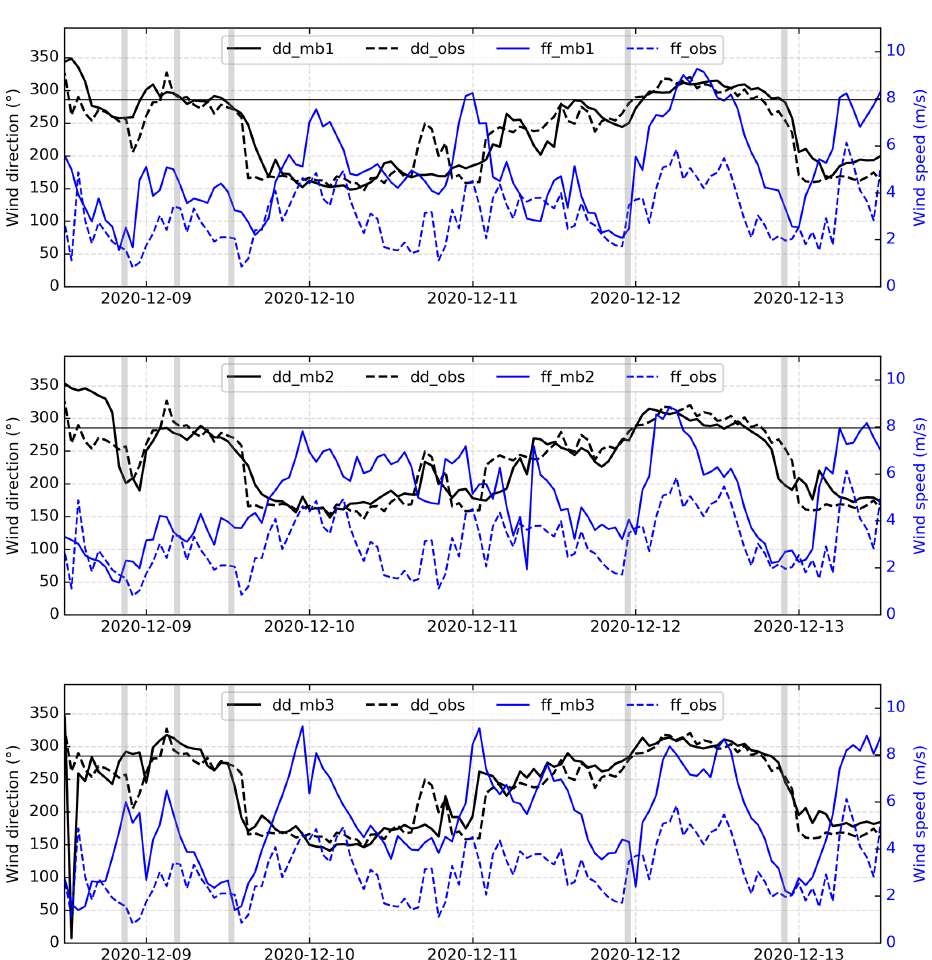
Figure 10. The three wind forecasts from AROME-EPS (solid curves) used to generate the pX simulations presented in Fig. 9, compared to wind observations stored at LRC (dashed curves); ff and dd denote, respectively, wind speed and direction, while mb1, mb2, and mb3 denote each of the three AROME-EPS members. The vertical gray lines shows the occurrence time of the five peaks presented in Table 4. The horizontal line shows the angle of the LRC station with respect to the source (286 ◦ ), which corresponds to the wind direction that transports the plume from the source to LRC.